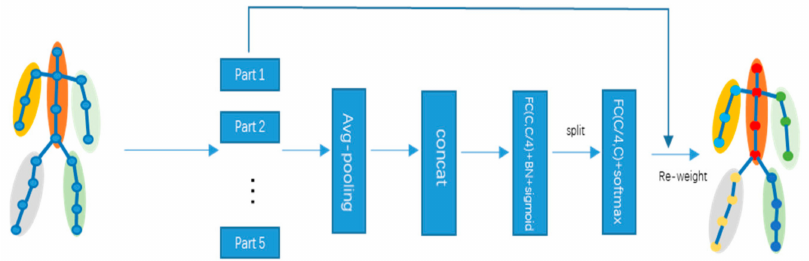
Figure 4. Illustration of the sub-graph attention